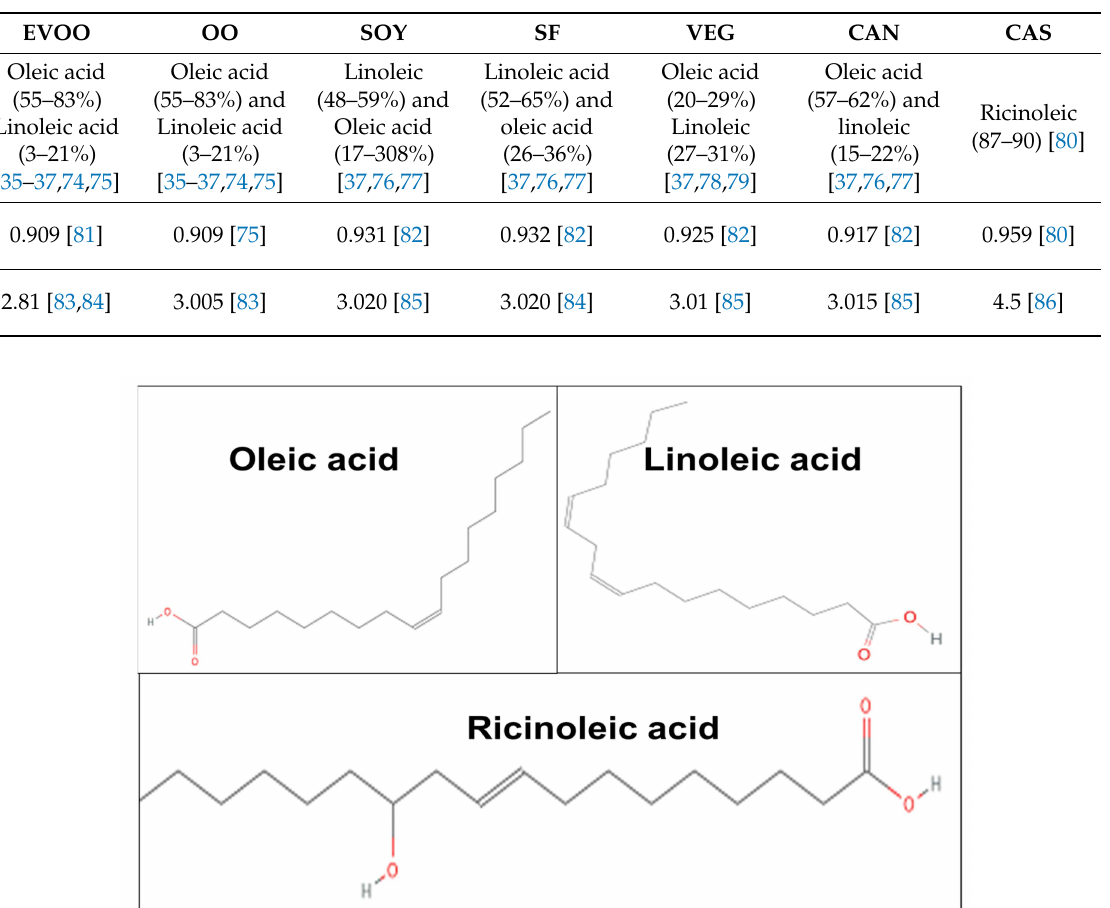
Table 1. Dielectric constant, fatty acid content and density of all oils used in this study. Extra virgin olive oil − EVOO, olive oil − OO, soybean oil − SOY, sunflower oil − SF, vegetable oil − VEG, canola oil − CAN and castor oil − CAS.